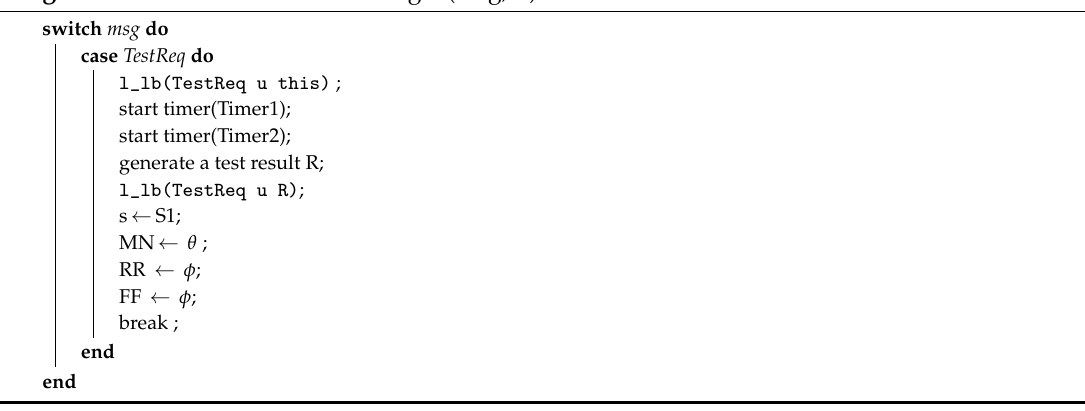
Algorithm 3: Procedure: ProcessMsgS1(msg, u).